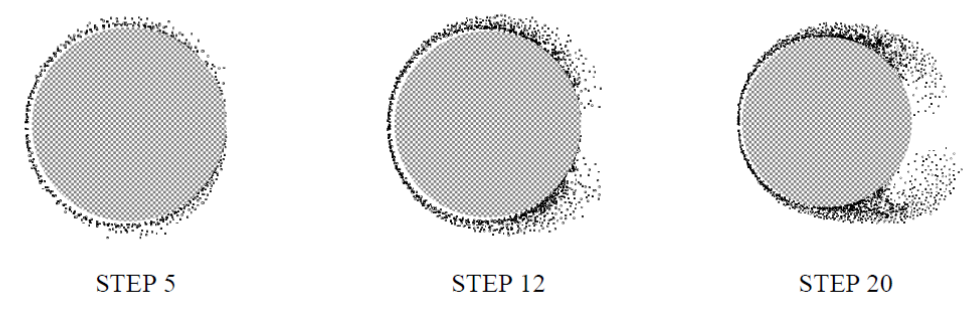
Figure 3. Starting flow around the smooth circular cylinder with no wall confinement.